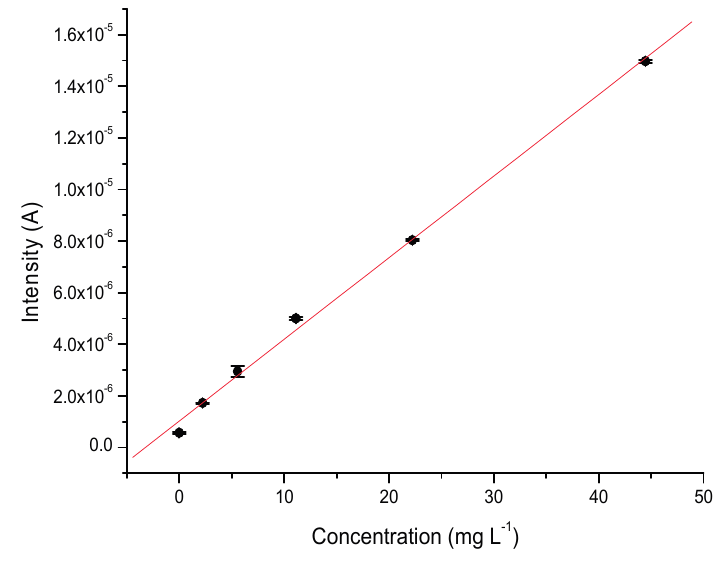
Figure 6. Calibration curve obtained for the MIP-TATP